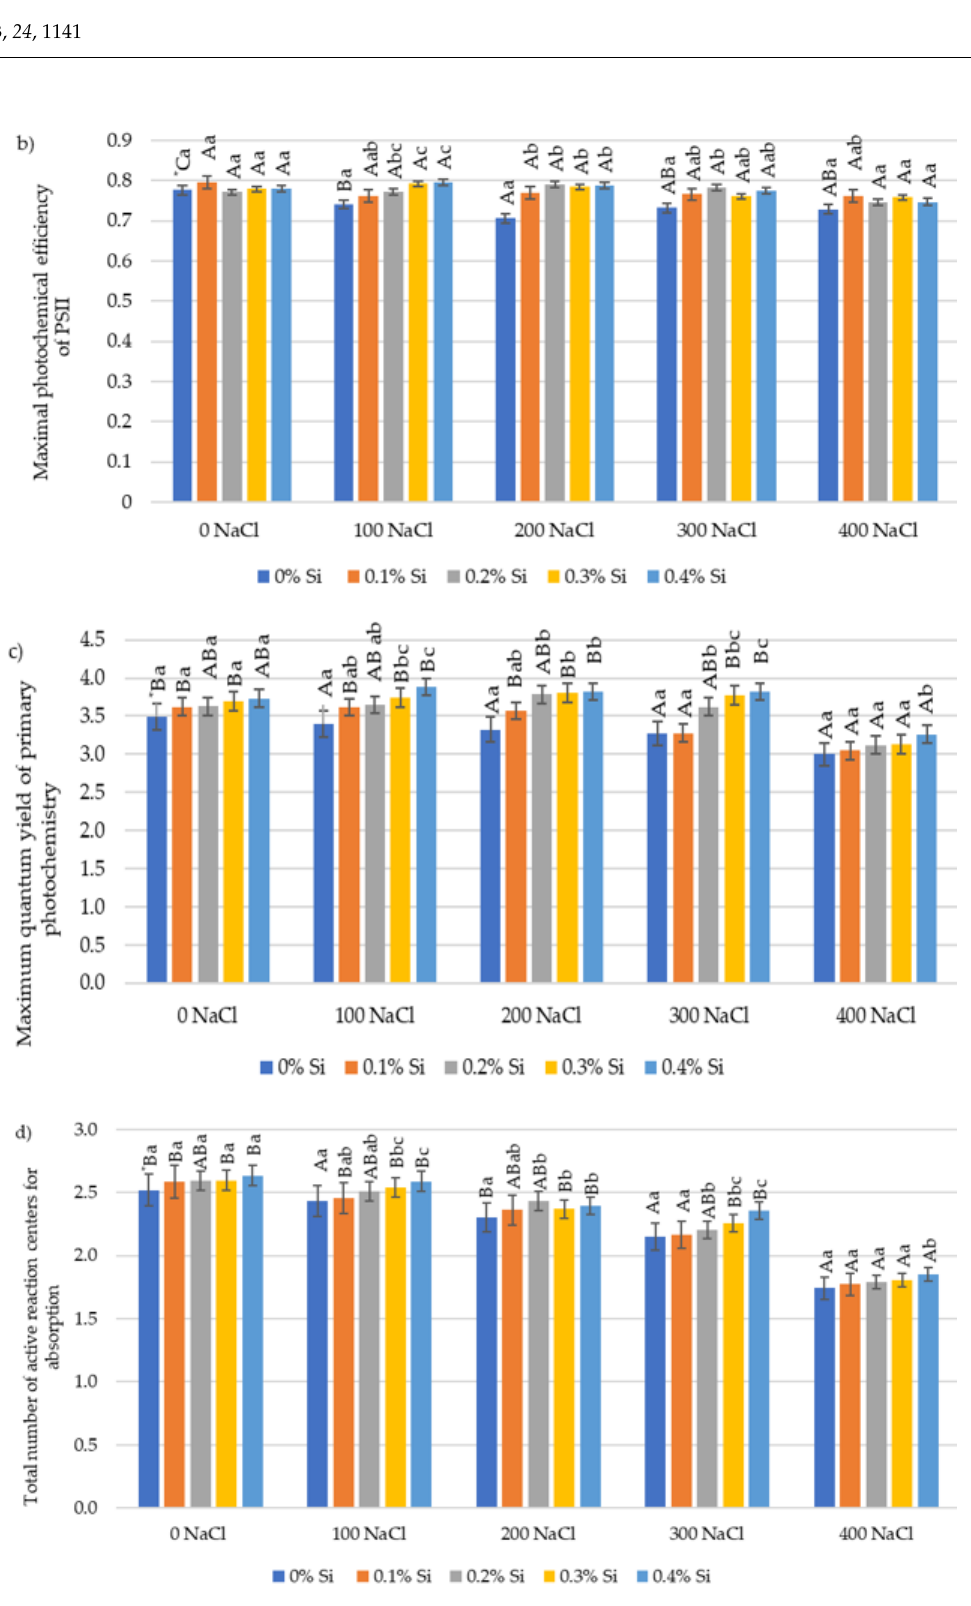
Figure 2. The effect of Si on chlorophyll fluorescence parameters: PS II performance index ( a ), maximal quantum yield of PSII photochemistry ( b ), maximum primary photochemistry yield ( c ) and total number of active reaction centers for absorption ( d ) in maize leaves grown under salinity stress. * Capital letters represent significant differences between the averages for soil salinity at the same doses of Si; lowercase letters represent the mean significant differences between the doses of Si at the same salinity ( p = 0.05).